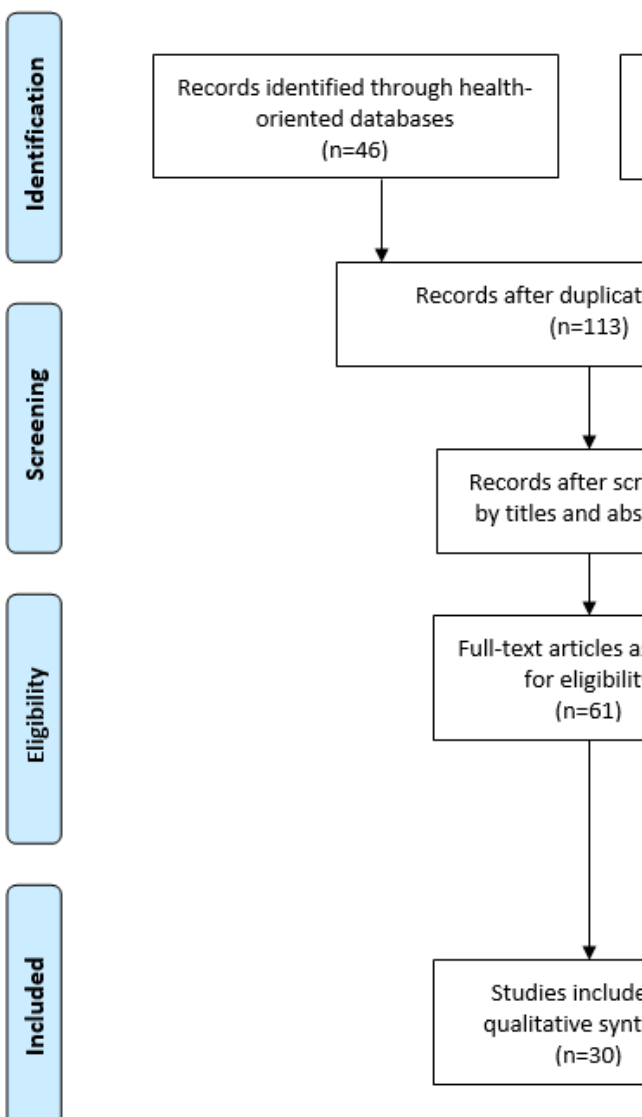
Figure 1. Search and screening